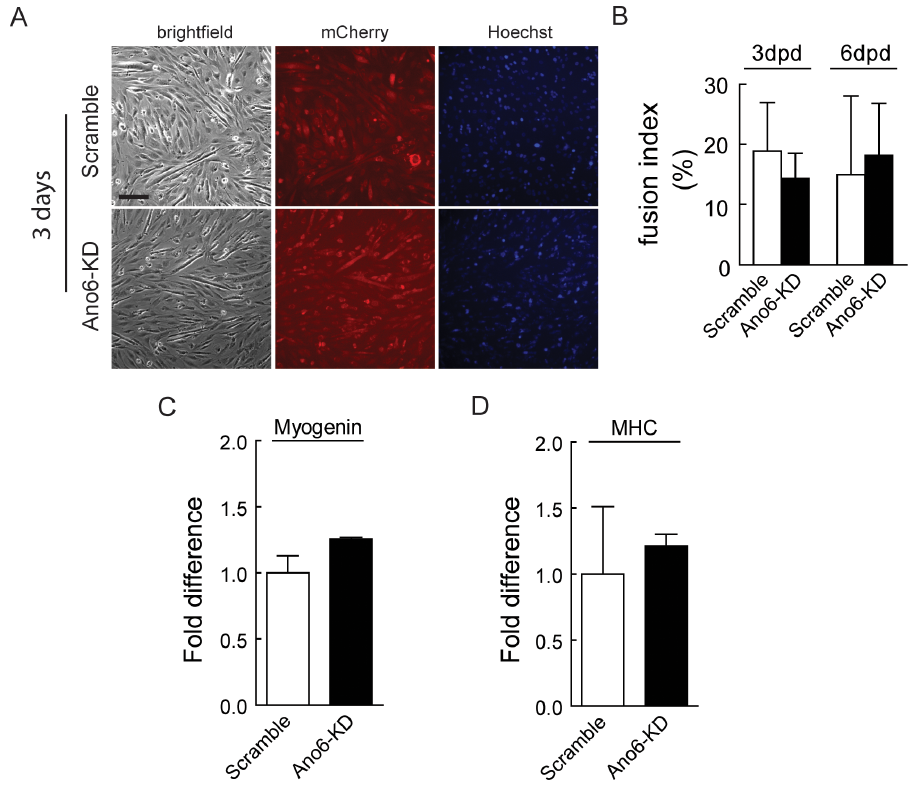
Figure 5. Representative micrographs of Scramble and Ano6 -KD C2C12 myotubes. (A) Scramble and Ano6 -KD stable cells, which also express mCherry, were imaged 3days after differentiation. (B) Fusion index of Scramble and Ano6 -KD stable C2C12 cells after differentiation for 3 days. Scale bar = 150 m m. (C,D) Fold difference of myogenin and myosin heavy chain (MHC) expression as examined by RT-PCR of C2C12 cells during differentiation.